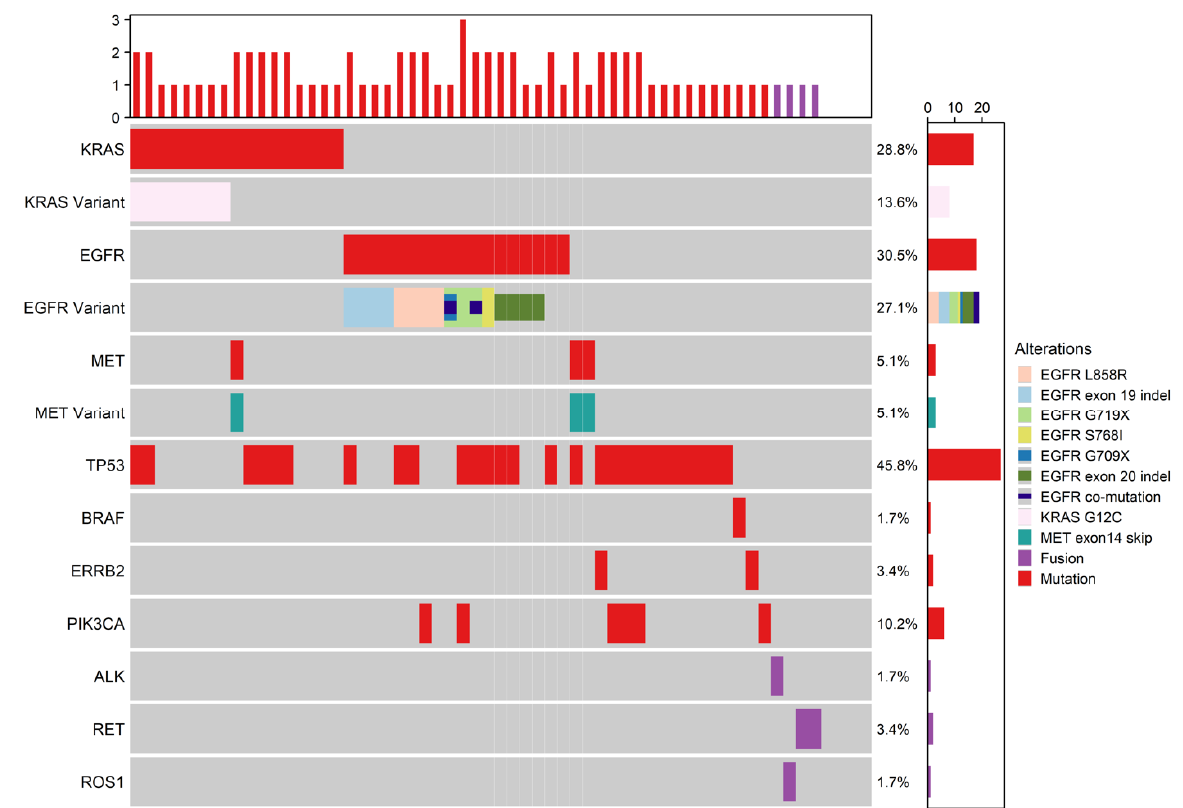
Figure 1. Oncoprint of the early stage NSCLC cohort genomic alterations. This oncoprint depicts genetic alterations identified by the Canexia Health Find It TM assay, a FPPE solid tumor DNA-based assay, and the RNA-based Fusions assay. On the right, the alteration frequency per gene is reported, with the corresponding gene labelled on the left side. The barplots beside the gene labels report the alteration counts. The topmost bar represents the mutation and fusion count per sample.